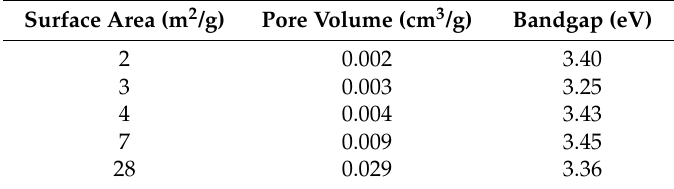
Figure 7. Diffuse reflectance spectra of Na 2 Ti 3 O 7 bare and deposited with Ni and Pt metals. Table 3. Textural and optical characterization of the synthesized catalysts.